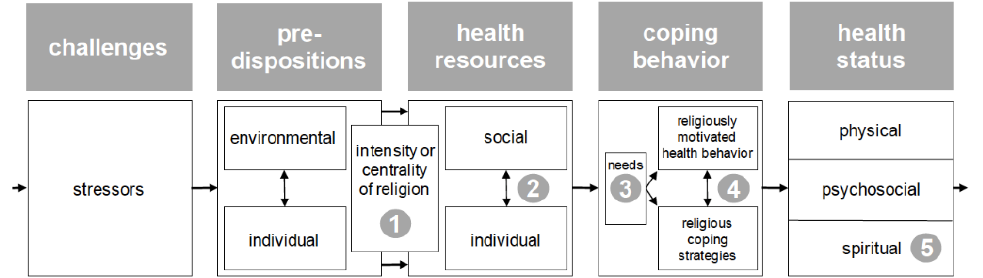
Figure 1. The vulnerability-stress model incorporating religiosity/spirituality (VSM-RS), which includes (1) centrality of religion, (2) R/S resources, (3) spiritual needs, (4) religious coping, and (5) spiritual